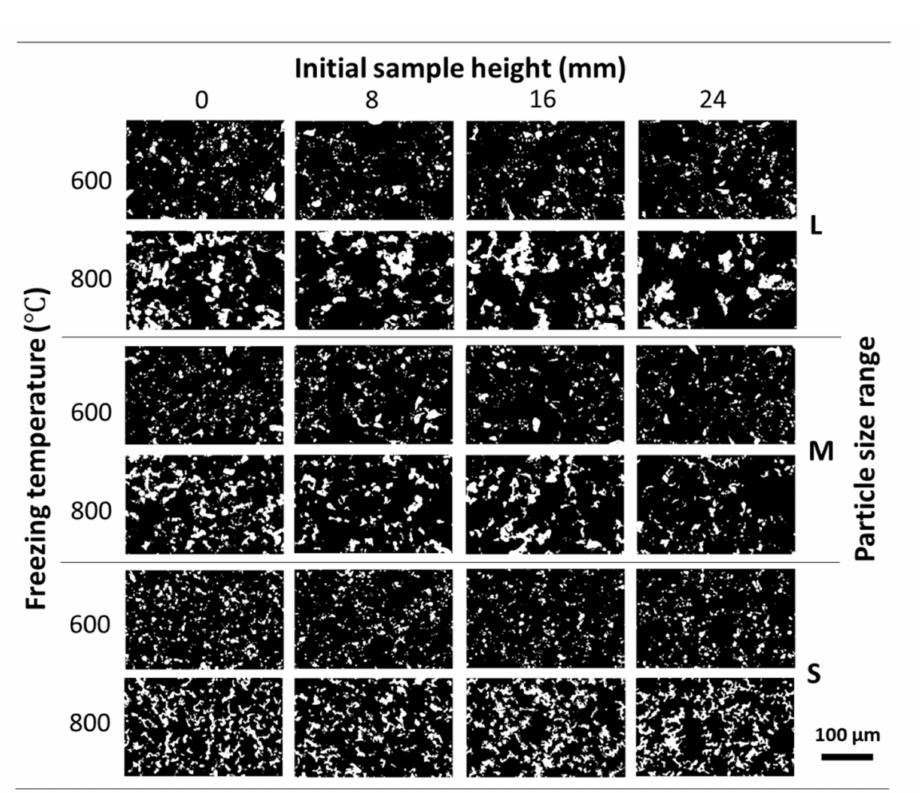
Figure 3. Evolution of the pore structure of the Ni wicks freeze-casted at 25 ◦ C across the initial sample height. OM micrographs show the effect of the different particle size ranges (L, M, and S) and sintering temperatures (600, and 800 ◦ C) employed. Pores are shown in black and Ni walls were in white